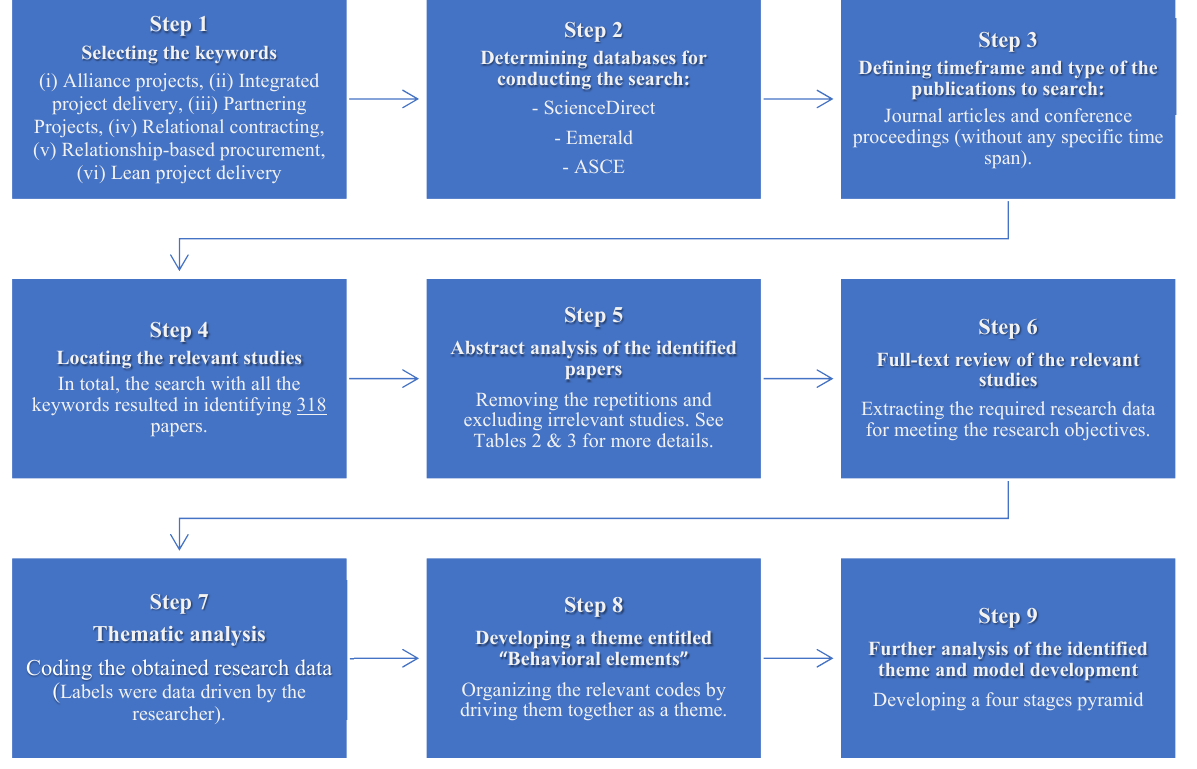
Figure 1. The research process including data collection and analysis.